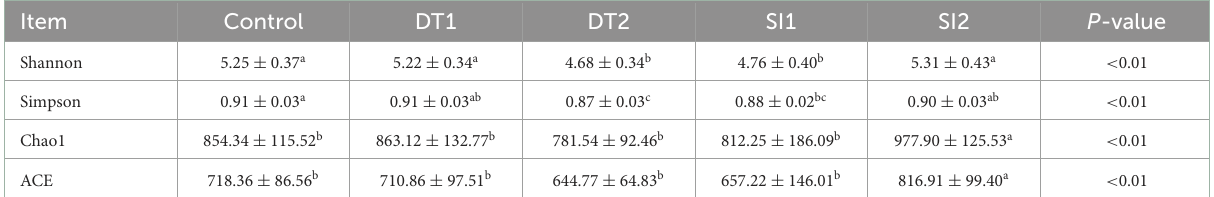
TABLE 7 The Effects of dietary supplementation with dandelion tannins or soybean isoflavones on the α -diversity indexes of cecal microbiota.